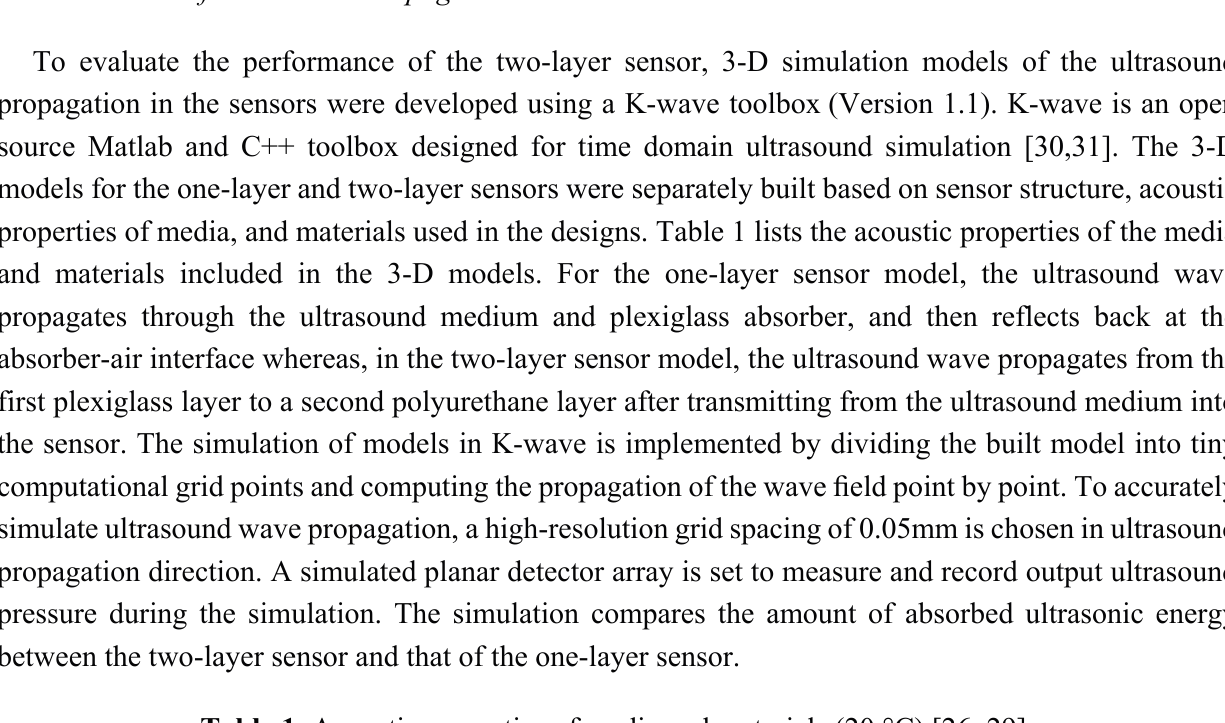
Table 1. Acoustic properties of media and materials (20 °C) [26–29].